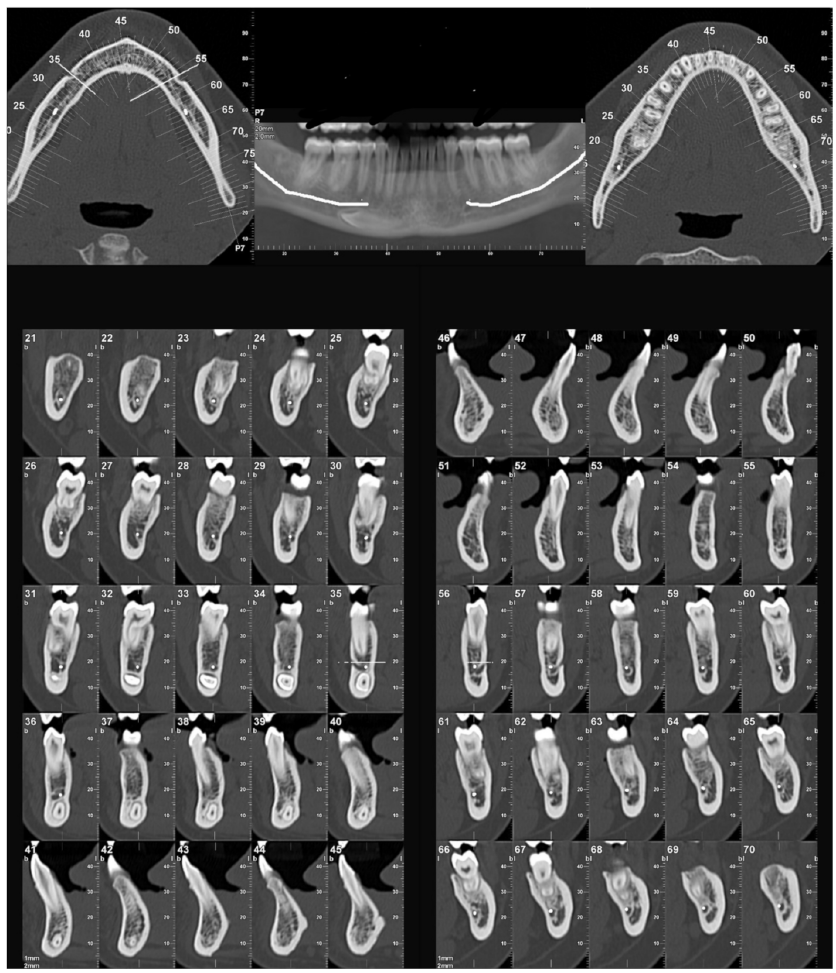
Figure 3. CBCT images with transmigrated canine type